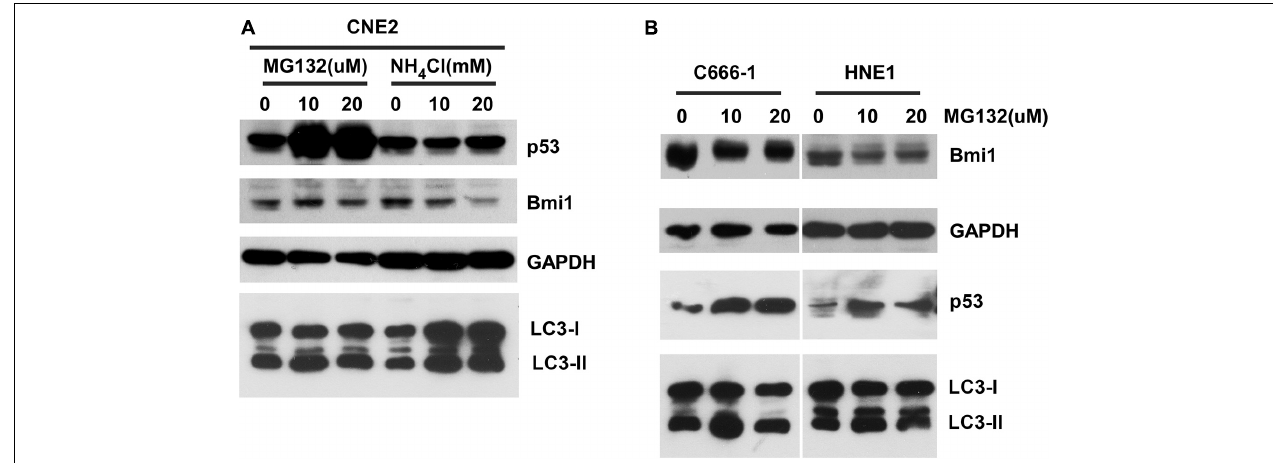
FIGURE 2 | The inhibitors proteasome and lysosome do not have effects on Bmi1 protein expression in nasopharyngeal carcinoma (NPC) cells. NPC cells CNE2 (A) , C666-1, and HNE1 (B) were seeded into six-well plates, then treated with the indicated concentrations of MG132 and NH 4 Cl for 8 h, then subjected to western blot. p53 served as the positive control for the role of MG132 in proteasomal degradation. LC3-II served as the positive control for the role of NH 4 Cl in lysosomal degradation. GAPDH was used as a loading control. The data represent three sets of independent experiments.